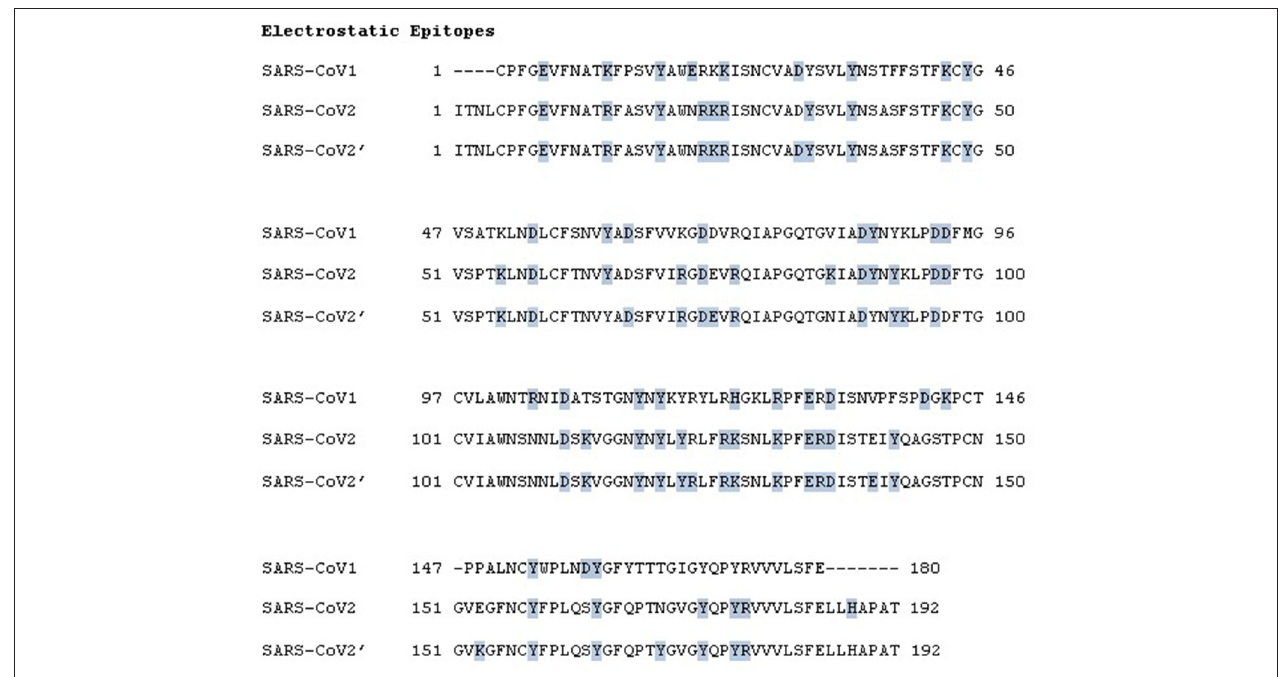
FIGURE 4 | Electrostatic epitopes. Primary sequences of the SARS-CoV-1S RBD, the SARS-CoV-2S wt RBD, and the SARS-CoV-2 ′ — representing the South African variant (B.1.351)—with the interface with ACE2 (shown in blue). Data obtained using the threshold | 1 pKa| > 0.01. Calculations for the RBD of SARS-CoV-2 ′ were performed with the structure RBD2 SA . Gaps are represented by “–.” The numbers next to the chains are used to guide the identification of the amino acid sequence numbers of the